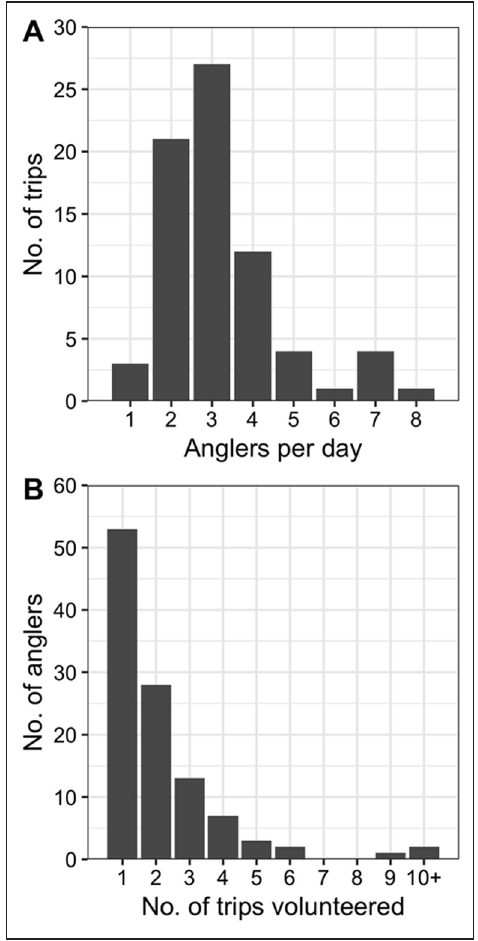
Figure 5: Number of A) anglers per day and B) fishing trips volunteered for by 109 volunteer anglers across 73 fishing trips across the five sampling